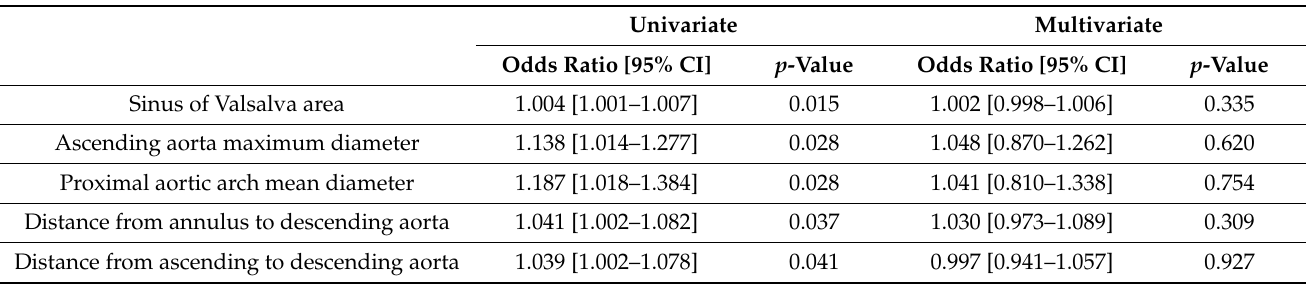
Table 3. Univariate and multivariate logistic regression model analysis of predictors for a low prosthesis position after